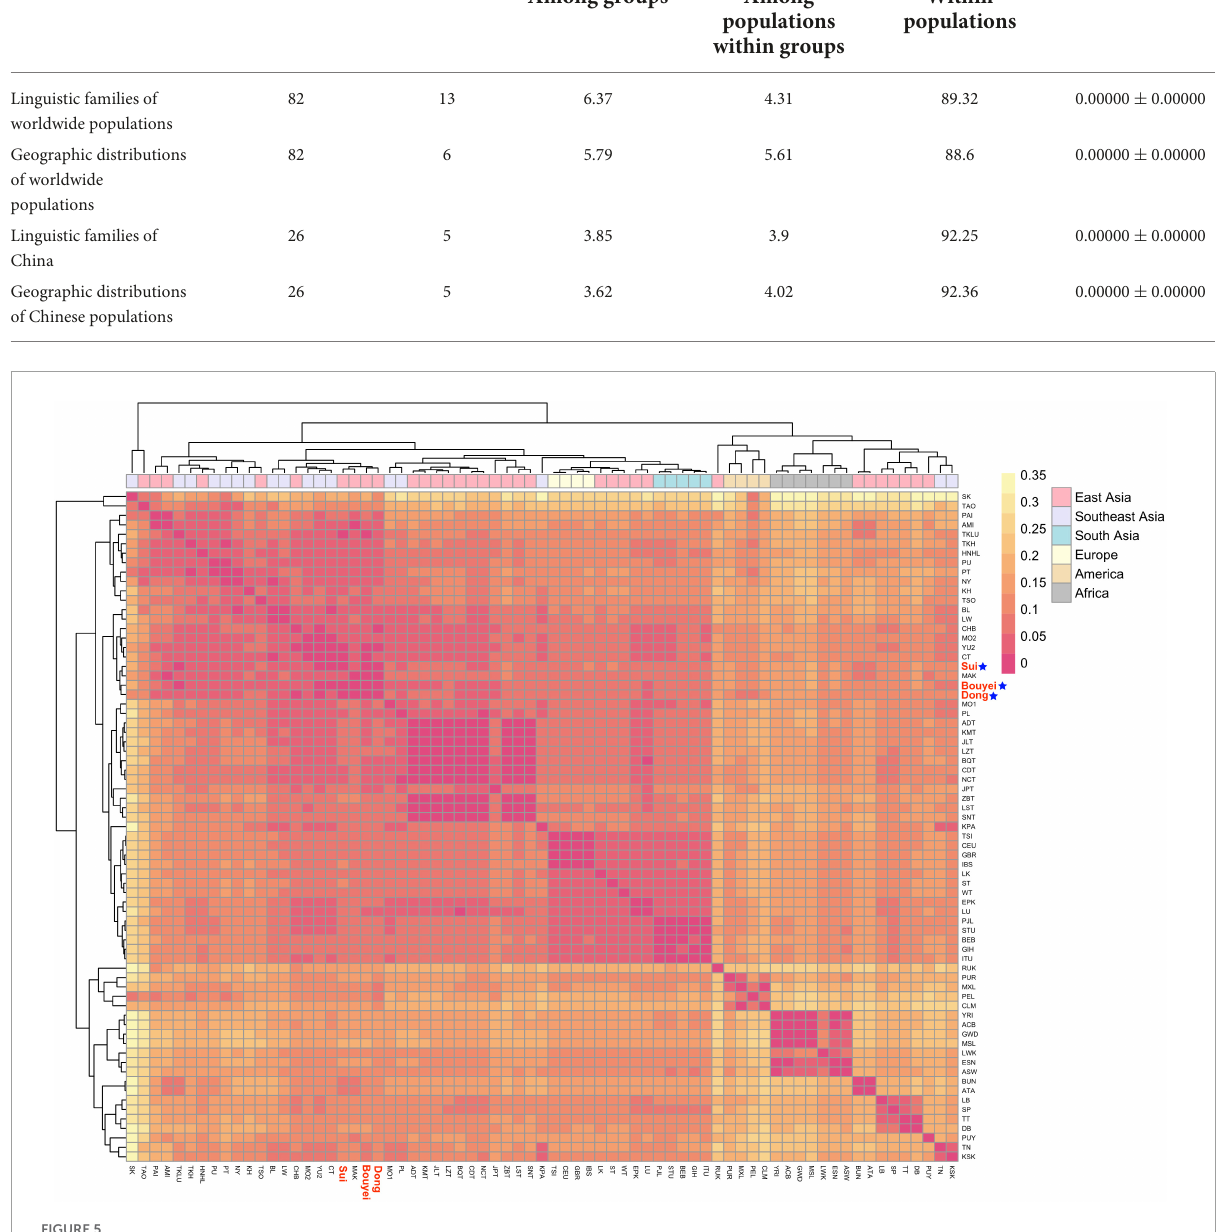
FIGURE5 Heatmap for genetic distance between three Guizhou Tai-Kadai-speaking populations and worldwide 68 populations. Visualizing the F ST values with different colors. Color yellow represents the high F ST values, red represents the low F ST values. Highlight the Sui, Bouyei, and Dong in red, followed by a blue five-pointed